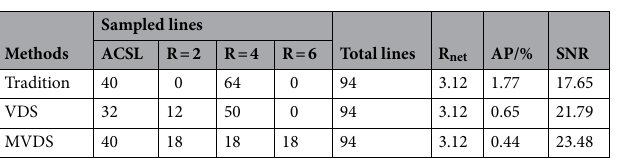
Table 4. The comparison of GRAPPA reconstruction images sampled using traditional method, VDS method, or MVDS method.